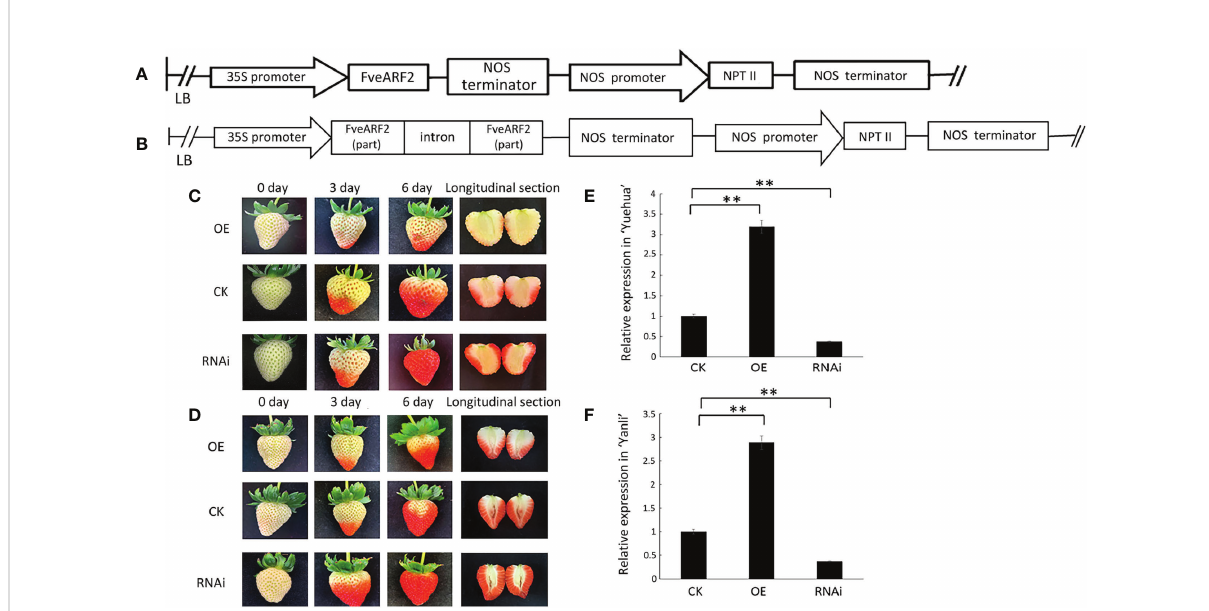
FIGURE 4 Phenotypic investigation of transgenic strawberry fruit. (A) Structural diagram of the vector used to overexpress FveARF2 using the CaMV 35S promoter. (B) Structural diagram of the FveARF2 - RNAi vector driven by the CaMV 35S promoter. (C) ‘ Yuehua ’ and (D) ‘ Yanli ’ fruit overexpressing FveARF2 matured later, while silencing FveARF2 induced fruit maturation in both cultivars when compared with the control. The relative expression of FveARF2 in transgenic (E) ‘ Yuehua ’ and (F) ‘ Yanli ’ fruit, respectively. Values are the mean ± SD from three independent experiments with three biological replicates. ‘ ** ’ Indicates very signi fi cant differences (P < 0.01, Duncan ’ s multiple range